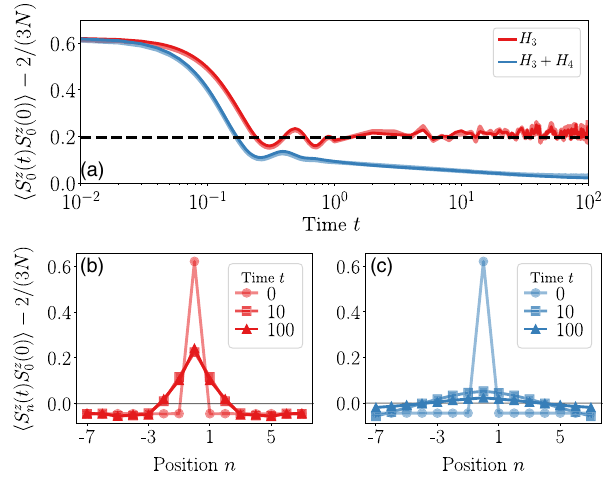
FIG. 1. Thermalization and its absence in the autocorrelation function. (a) shows the autocorrelation function C z 0 ð t Þ ≡ h S z 0 ð t Þ S z 0 ð 0 Þi in the full Hilbert space at an infinite temperature for N ¼ 13 (transparent curves) and N ¼ 15 (opaque curves) spins. For Hamiltonian H 3 in Eq. (1), C z 0 ð t Þ saturates to a finite value at long times, closely matching the lower bound in Eq. (4) (dashed line). The autocorrelation function of the combined Hamiltonian H 3 þ H 4 decays to zero at long times. (b) and (c) show the spatially resolved correlator h S z n ð t Þ S z 0 ð 0 Þi for H 3 and H H 3 þ 4 ,